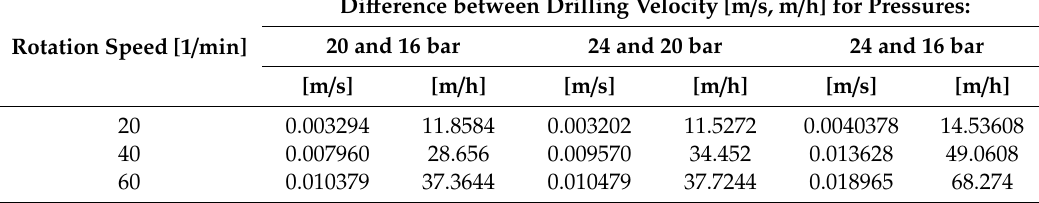
Table 5. Di ff erences between drilling velocity measured for various air pressures and drill rotation speeds of the 127 mm diameter drill bit, in the interval 72–90 m below ground level.